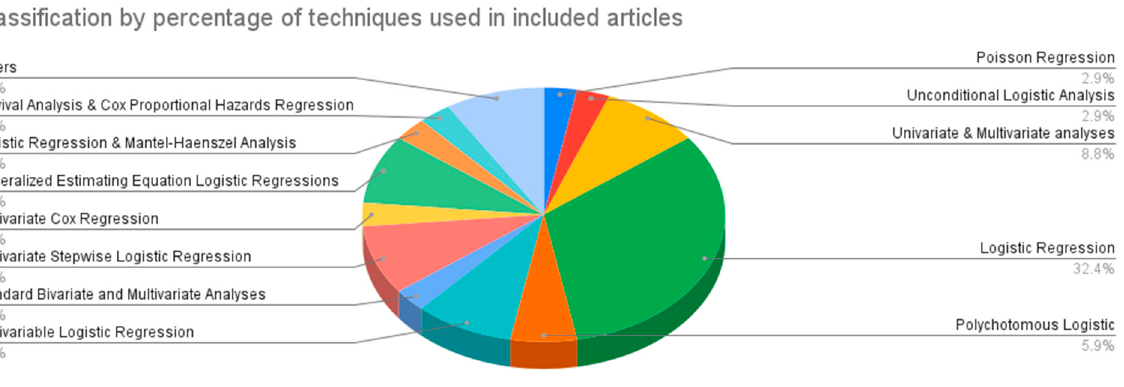
Figure 3. Application of statistical methods concerning the perspective of a clinician.